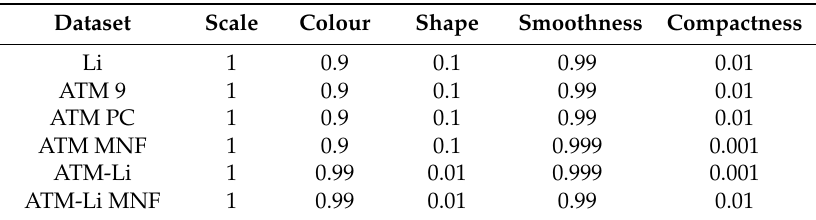
Table 3. Parameter values used to perform image segmentation for each input dataset (please refer to Table 2 for a description of the